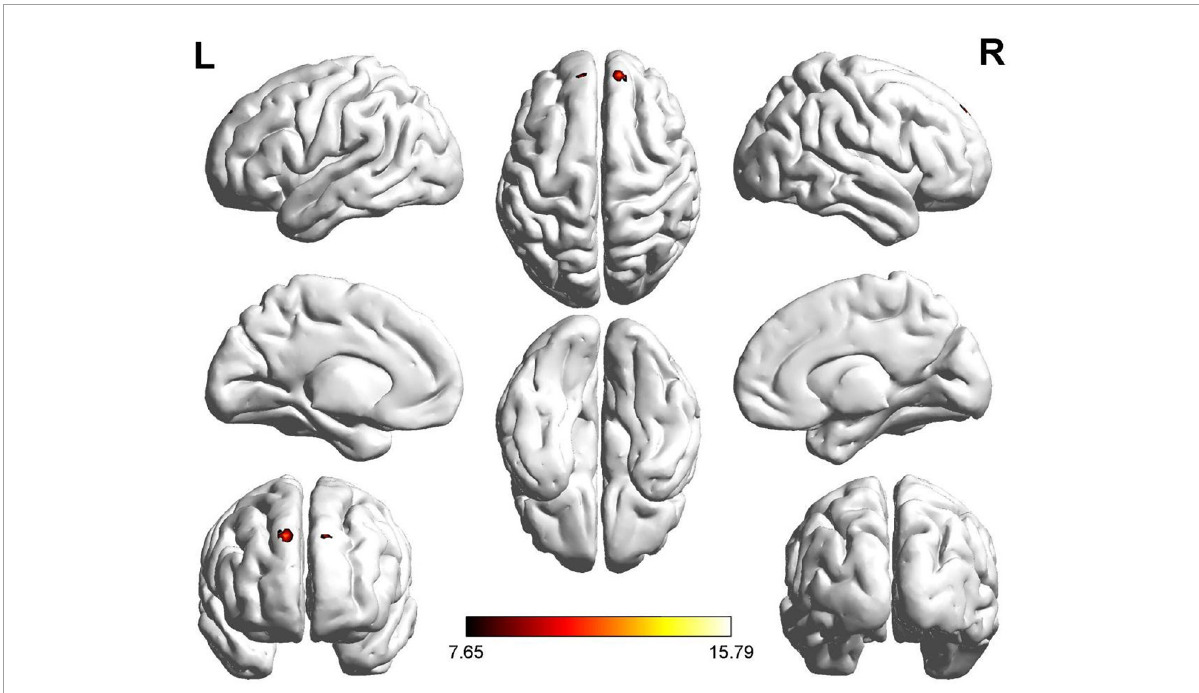
FIGURE1 Significant differences in ALFF values were observed in the left and right dorsolateral SFG and rectus gyrus for both Recent-onset Tinnitus (ROT) and Persistent Tinnitus (PT) groups, compared to the healthy control group.